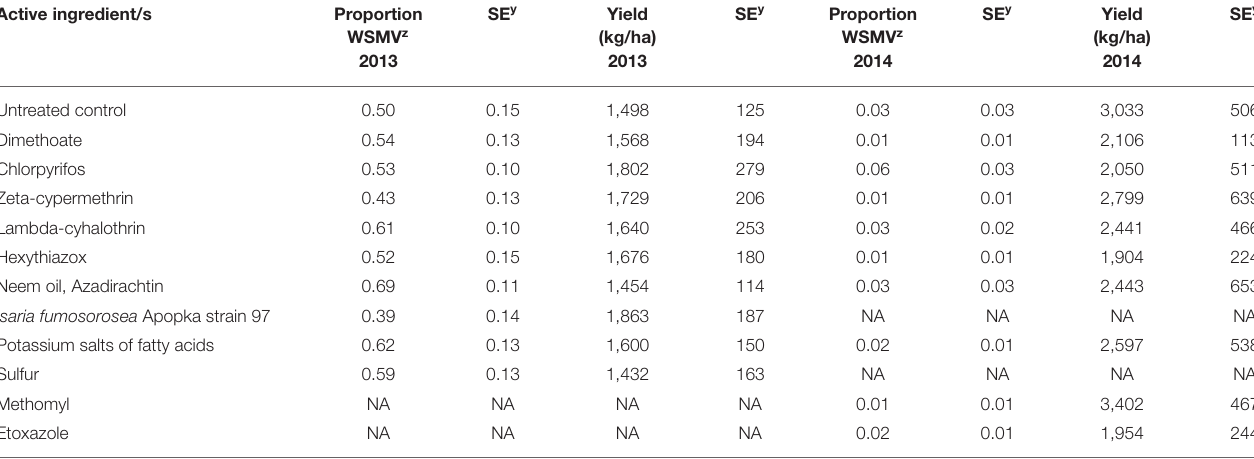
y Standard error of the mean. z Average proportion of leaves (n = 30) per plot infected with WSMV determined by ELISA.